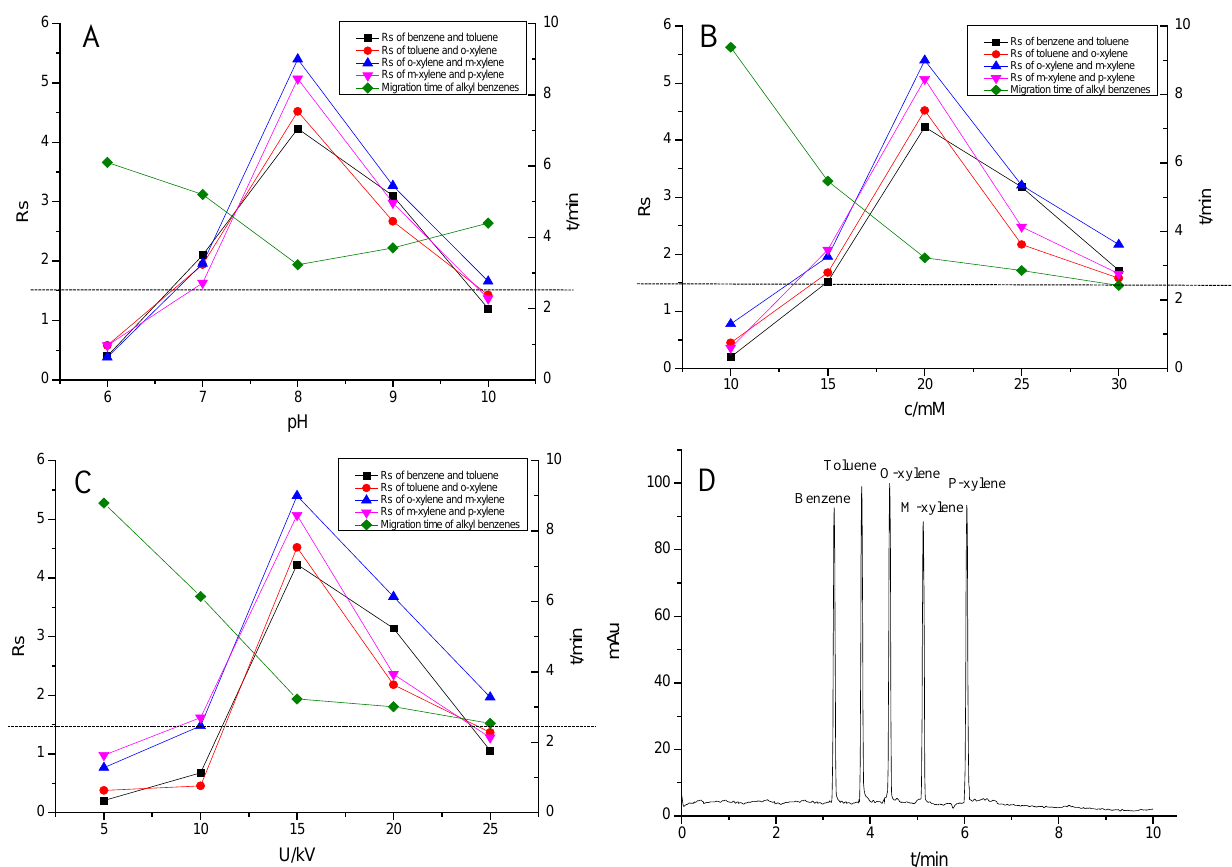
Figure 7. Effect of experimental conditions on the separation of the alkyl benzenes: ( A ) pH, ( B ) buffer concentration, ( C ) operating voltage and ( D ) separation chromatogram of the alkyl benzenes on the TpBD COF immobilized capillary. Experimental conditions: sample, 5.0 mg · mL − 1 mixture solution of alkyl benzenes; temperature, 20 ◦